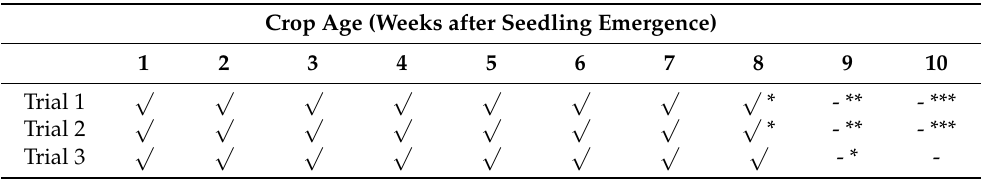
Table 2. Crop age (weeks after seedling emergence), at which insecticide applications were completed for control of Spodoptera frugiperda in maize under natural infestation (trials 1, 2 and